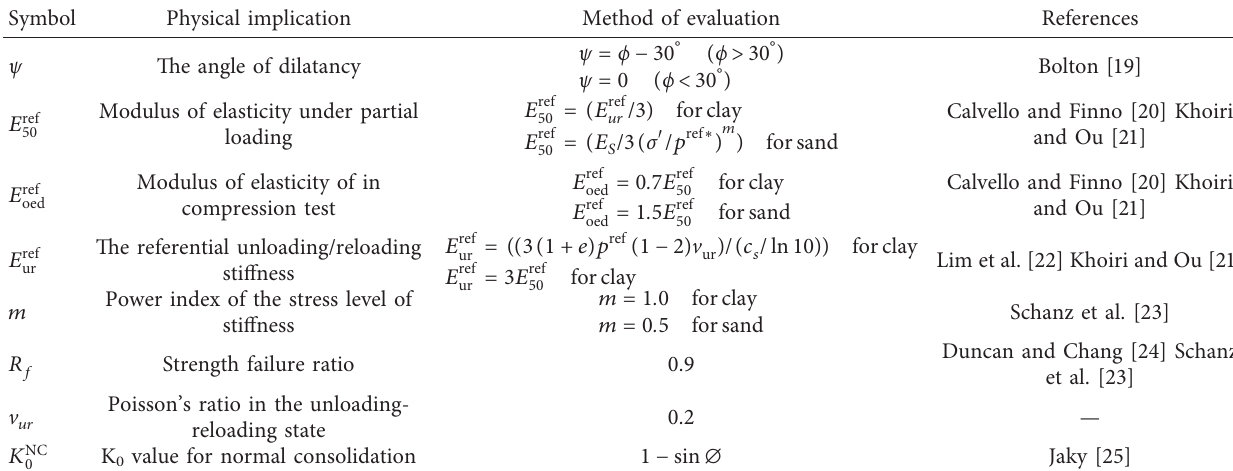
Table 1: Parameters of the HS model.